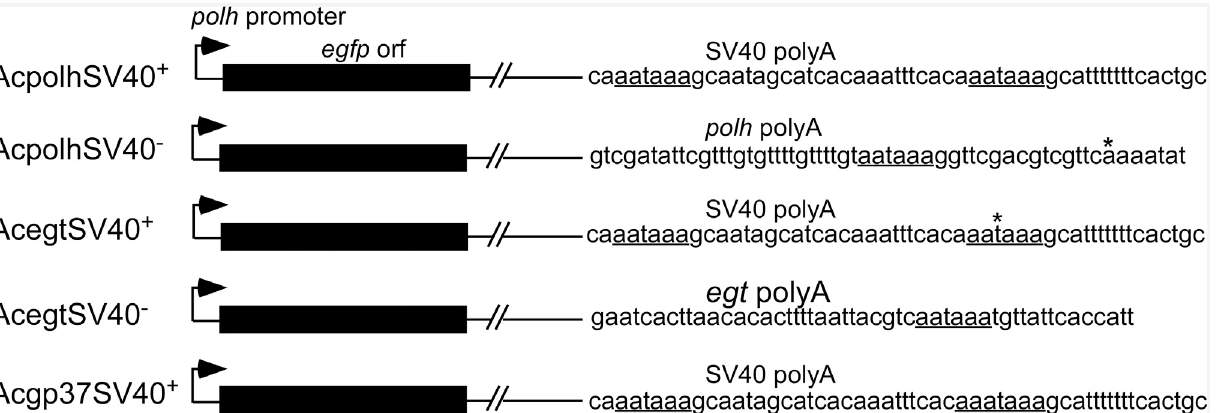
Fig 5. Mapping of the 3 ’ ends of the egfp transcripts from the Sf21 cells infected with different viral constructs with or without the SV40 polyA signal showing the polyA signal (AATAAA) upstream of the 3 ’ end of transcripts (not drawn to scale). * indicates alternative 3 ’ ends. // indicates sequences